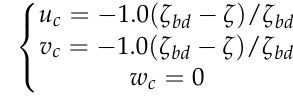
Table 1. Description of system parameters.